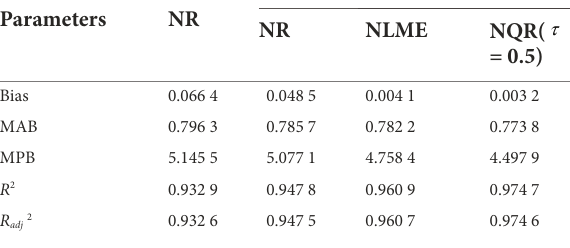
TABLE 9 Goodness-of-fit statistics of Kozak (2004) for the four different forms using validation data.